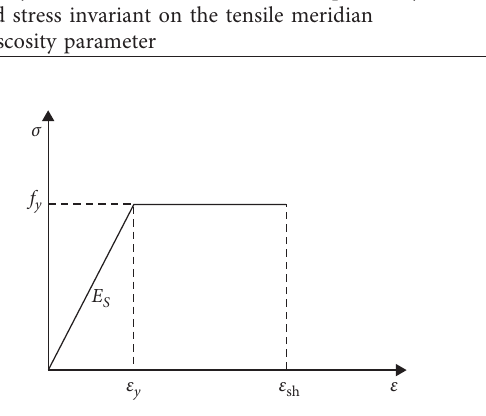
Figure 7: Constitutive model for reinforcing